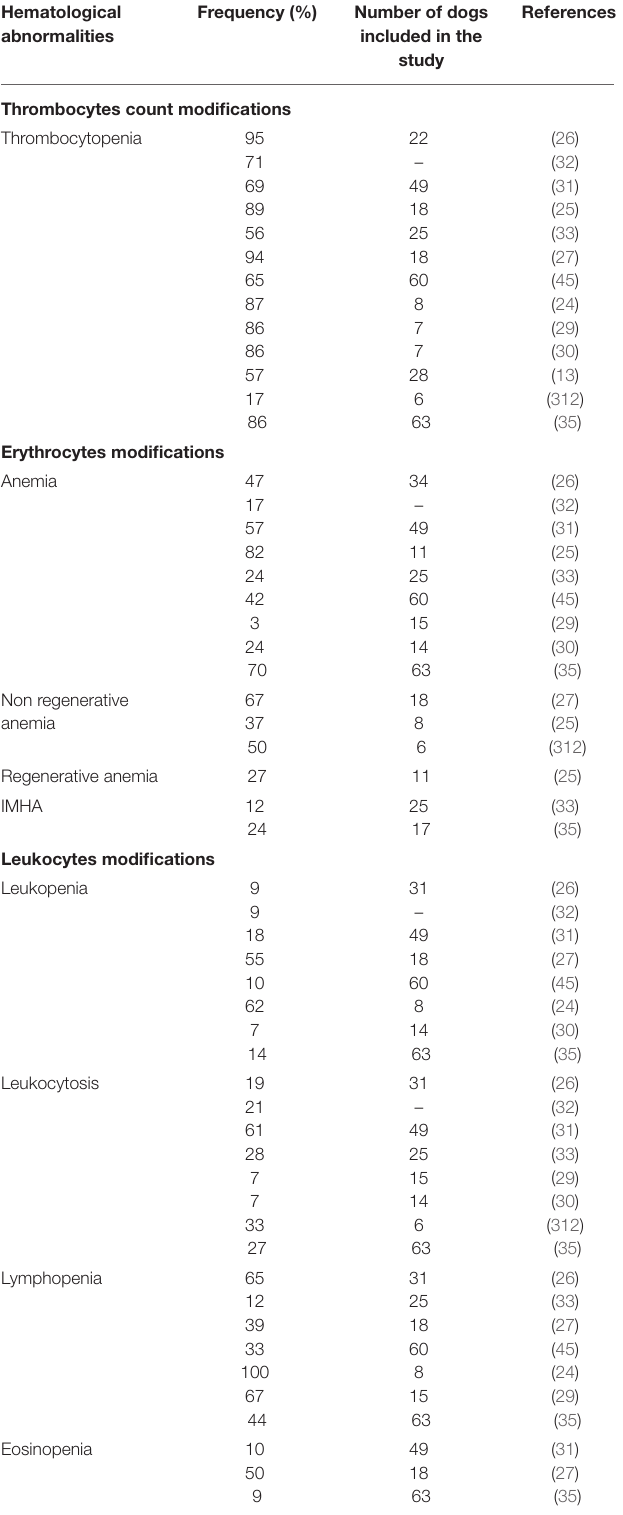
TABLE 3 | Hematological abormalities associated with canine granulocytic anaplasmosis after natural infection and corresponding frequency recorded in several